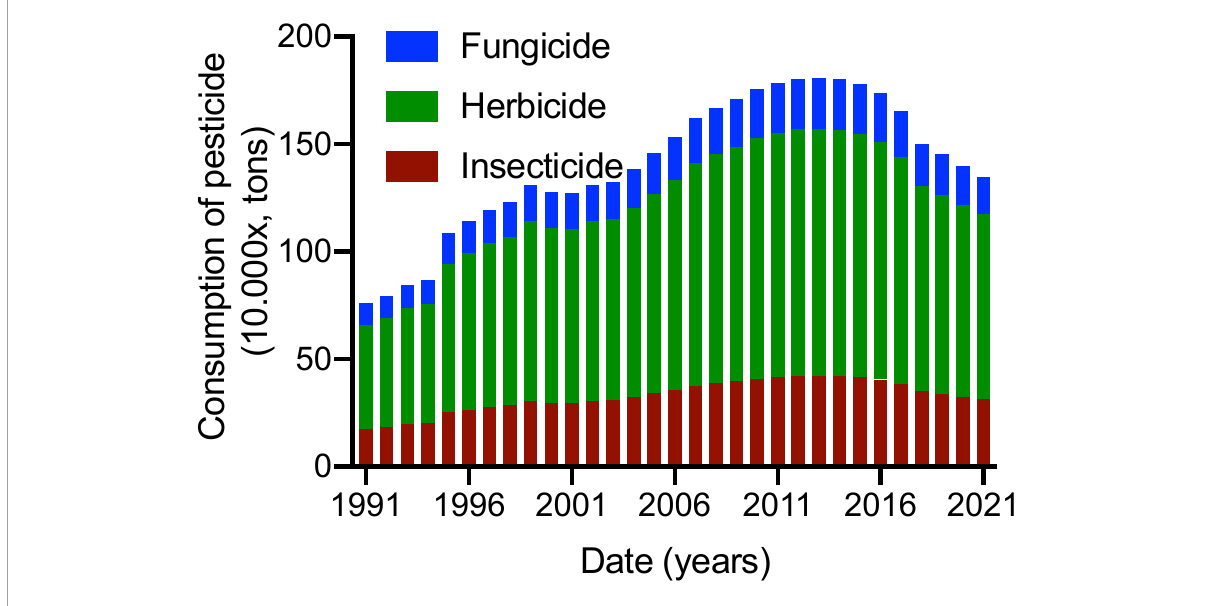
FIGURE2 Chemical pesticide consumption in China from 1991 to 2021. Pesticides include fungicide, herbicide, and insecticide.